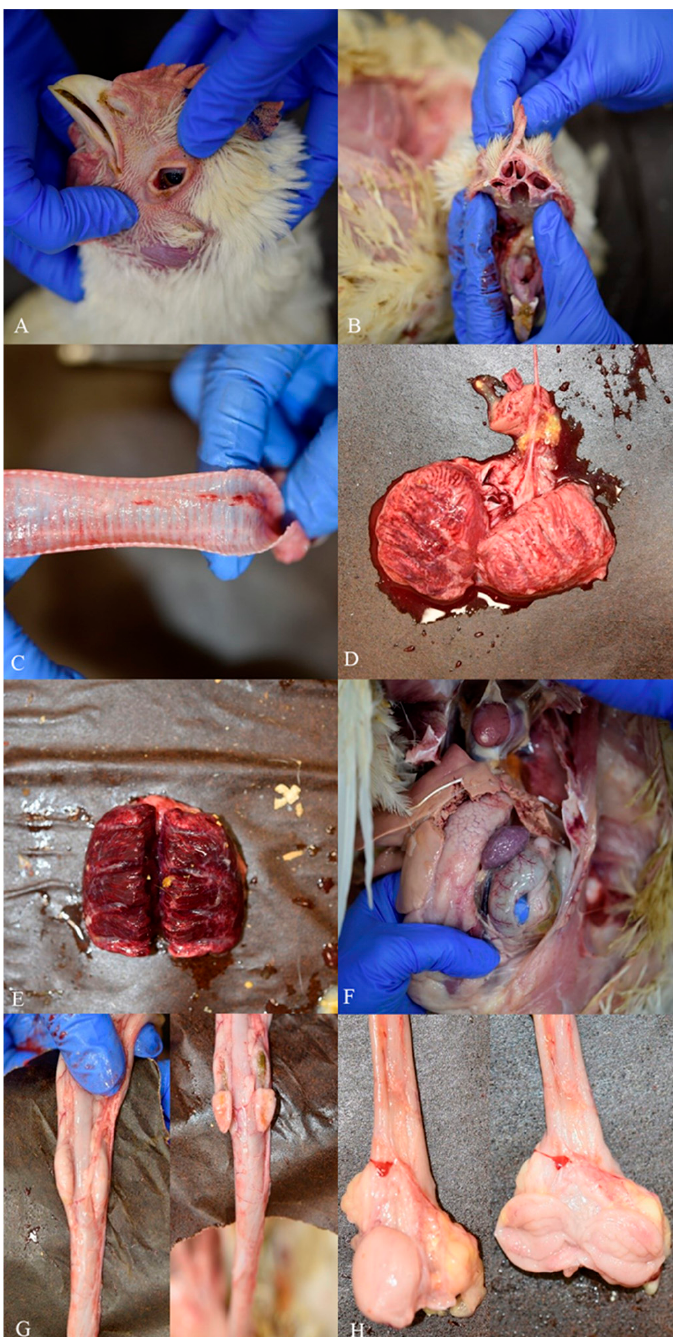
Figure 4. Main gross-pathology findings in infected birds of house 1. ( A ) Eye: moderate to severe conjunctival congestion and mild serous conjunctivitis. ( B ) Nasal cavities: mild hyperemia of nasal mucosa with serous debris not associated with diffuse oedema. ( C ) Trachea: hyperaemia, petechial haemorrhages and serous-catarrhal luminal exudation are visible on the mucosal surface. ( D , E ) Lungs: bilateral, moderate to severe, focally extensive to diffuse, pulmonary consolidation with edema, congestion and haemorrhages. ( F ) Spleen: splenomegaly with diffuse, miliary whitish spots. ( G ) Cecal tonsils: external ( left ) and cut ( right ) surface. Moderate hyperplasia with multifocal, red to light orange, small patches on the cut surface. ( H ) Bursa of Fabricius : external ( left figure) and inner ( right figure) surface. Moderate hyperplasia and mild mucosal